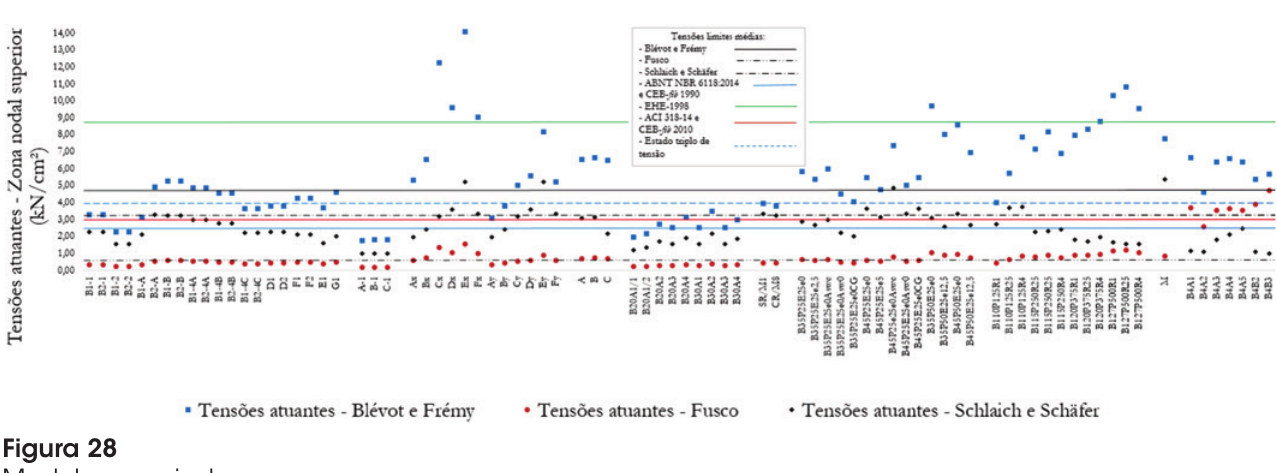
Modelos ensaiados × σ